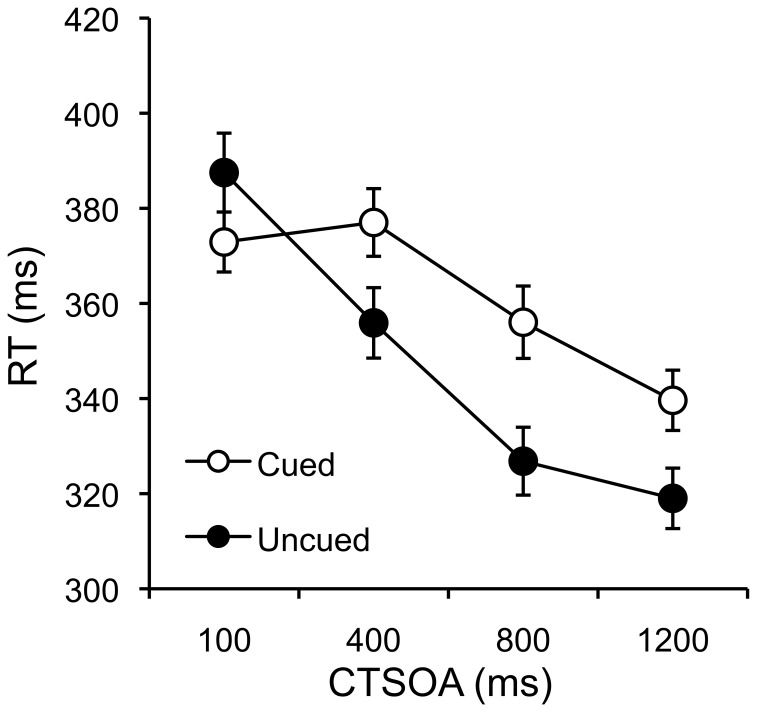
Visual Cuing: Cued and Uncued Mean RTs as a function of CSTOA.Mean RTs for cued and uncued trials as a function of cue-target stimulus onset asynchrony with standard error bars.